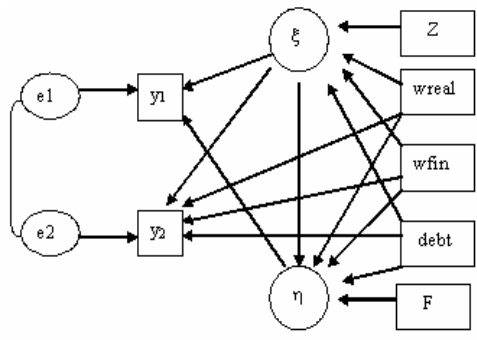
Fig. 1 – Path diagram of bidimensional HC